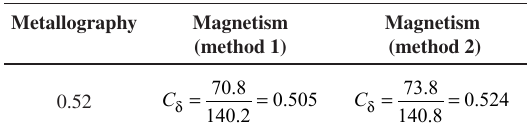
Figure 6. Microstructure of specimen LD-melt (as Table 3. Comparison between methods for quantification of C δ (specimen LD-ST).